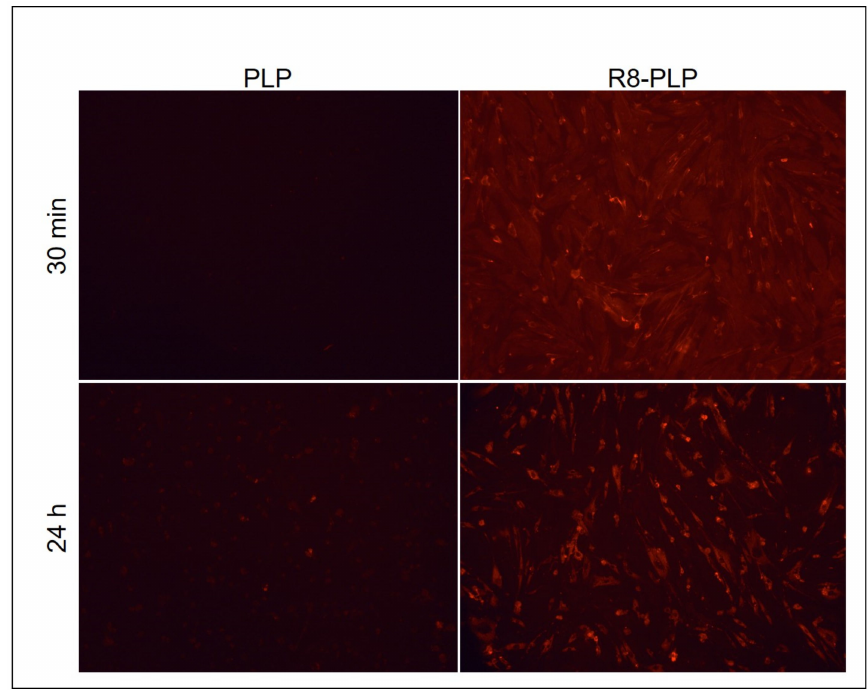
Figure 9. R8-PLP nanoparticles demonstrated enhanced cell association in